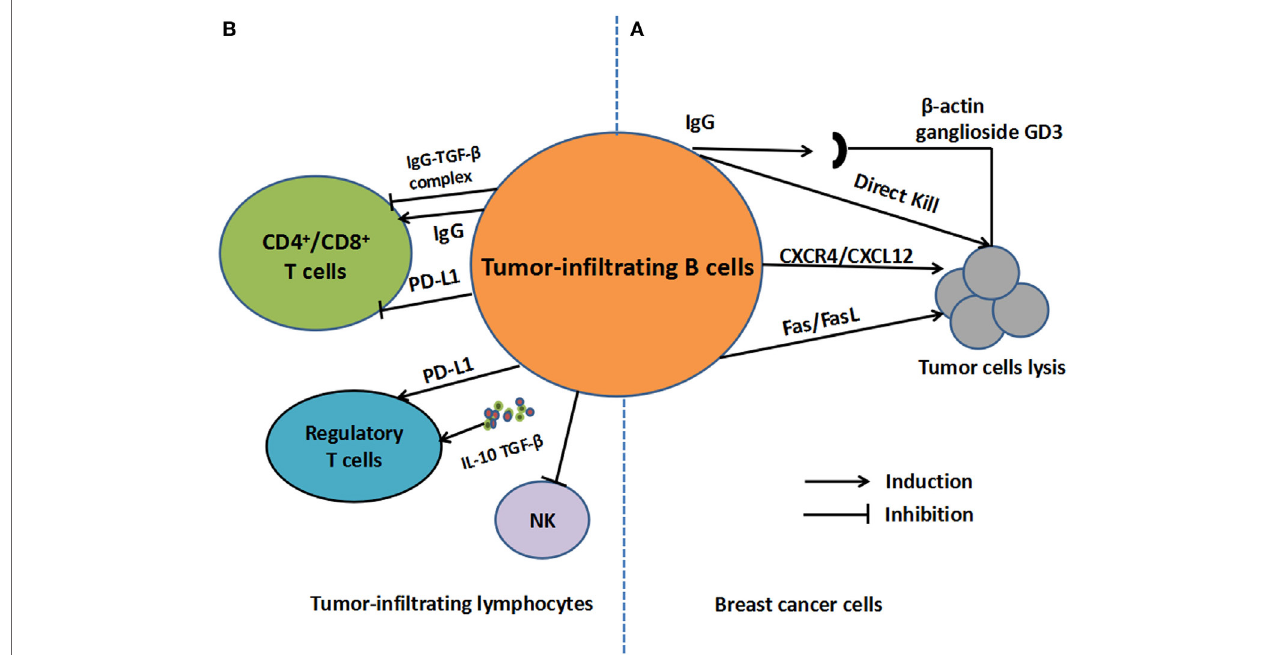
FiGURe 1 | The regulatory mechanisms of tumor-infiltrating B cells (TIL-B) in breast cancer. (A) For tumor cells, antigens including β -actin and ganglioside GD3, which are derived from cancer cells, can be recognized by TIL-B. TIL-B can also kill tumor cells directly. Moreover, TIL-B can kill cancer cells in CXCR4/CXCL12 pathways by cell-to-cell contact or through Fas/FasL pathways. (B) For other tumor-infiltrating lymphocytes, regulatory functions on regulatory T cells may be engendered through secretion of IL-10 and transforming growth factor (TGF)- β as well as overexpression of PD-1-ligand (PD-L1). As for T-cell response, IgG secretion can facilitate DC-induced T-cell response or inhibit cytotoxic T cells response in the form of IgG-TGF- β complex. T cell inhibition by PD-L1 expression is also involved in the